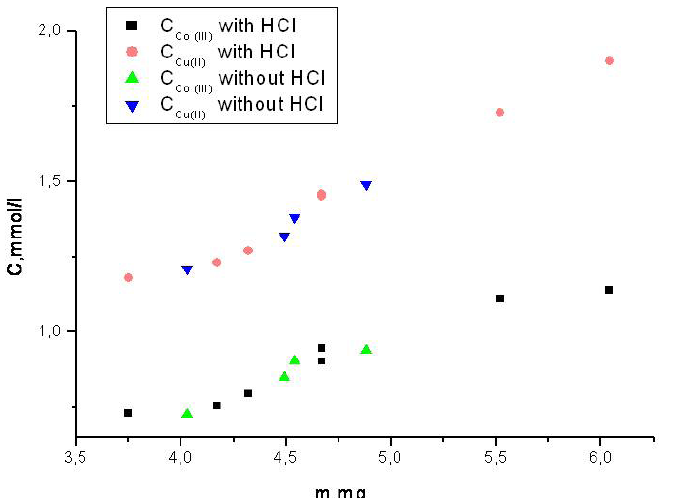
Figure 3. Influence of HCl on Co(III)-EDTA and Cu(II)-EDTA concentrations in the presence of 10 mmol KCl, 0.025 mmol Co(II) and 0.25 (0.15+0.10) mmol